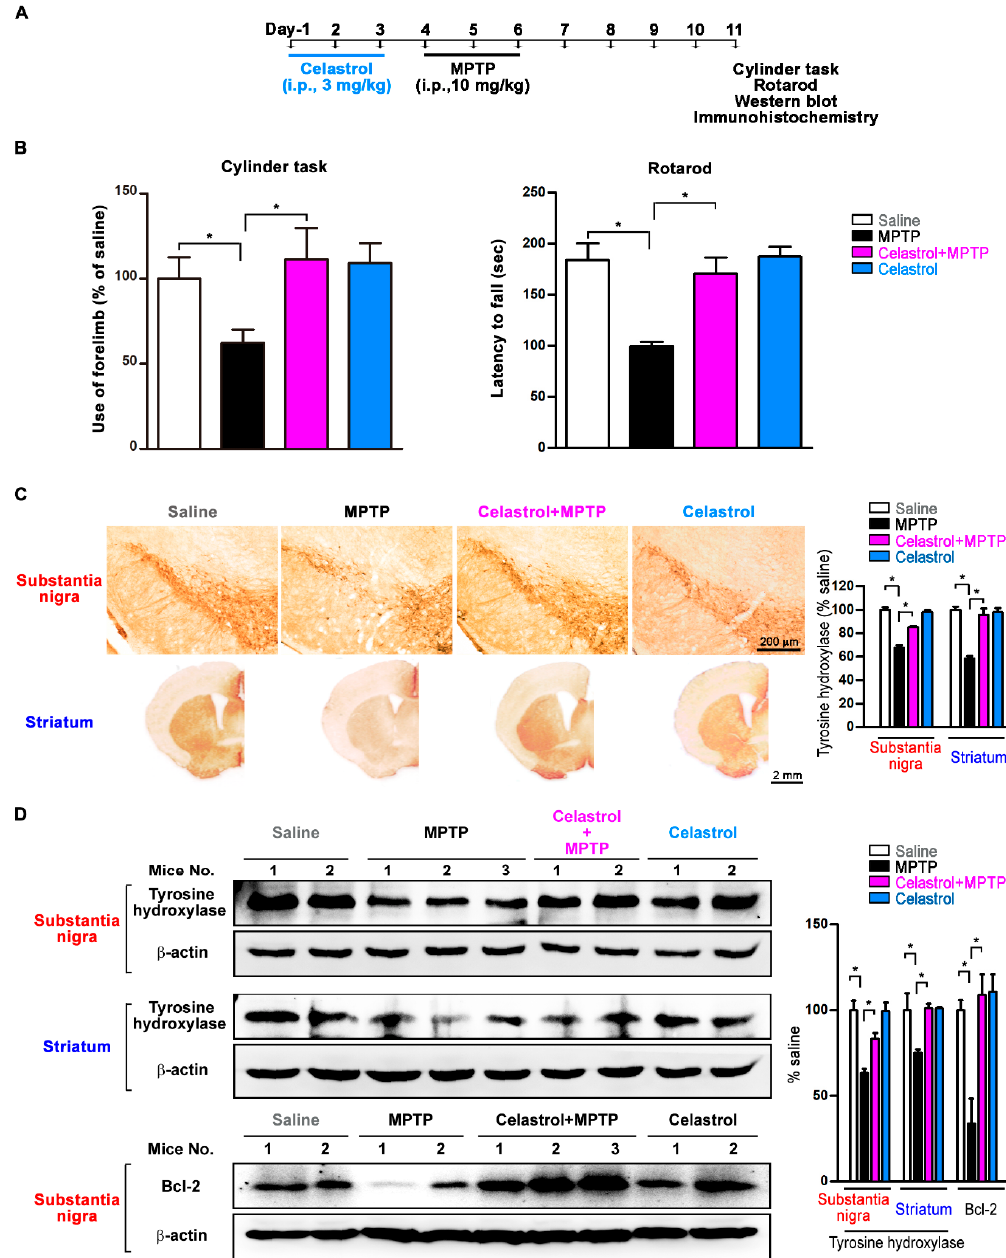
Figure 3. Celastrol improves motor symptoms and inhibits dopaminergic neurodegeneration in the 1-methyl 4-phenyl-1,2,3,6-tetrahydropyridine hydrochloride (MPTP) mouse model of PD. Systemic MPTP injections (i.p., 10 mg/kg/day for 3 days) induced substantia nigra dopaminergic neuronal loss and nerve terminal degeneration in the striatum on both sides of the nigrostriatal dopaminergic pathway. ( A ) The experimental protocol using celastrol to treat MPTP-induced PD mouse models. ( B ) On the last study day (Day 11), cylinder and rotarod results show that MPTP but not celastrol treatment reduced forelimb usage and the latency to fall as compared to saline control. Celastrol cotreatment with MPP + significantly increased forelimb usage and the latency to fall on Day 11 as compared to MPTP. ( C ) Immunohistochemistry staining of tyrosine hydroxylase data indicates that MPTP but not celastrol induced neurodegeneration in the substantia nigra and striatum as compared to saline control. In